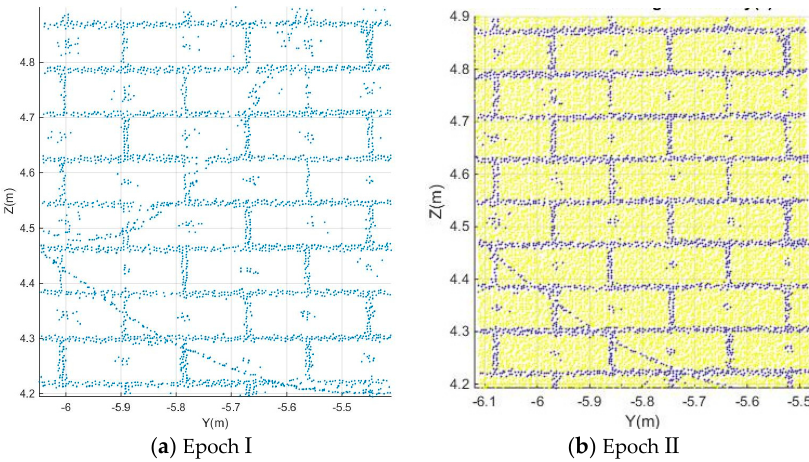
Figure 10. Results of separating brick points from notably mortar points in patch A using k-means clustering, with k = 2. Blue points correspond to mortar points, point reflecting from small photogrammetric targets attached to the brick centres, or to some wires in front of the wall. The yellow points in general belong to brick surfaces.